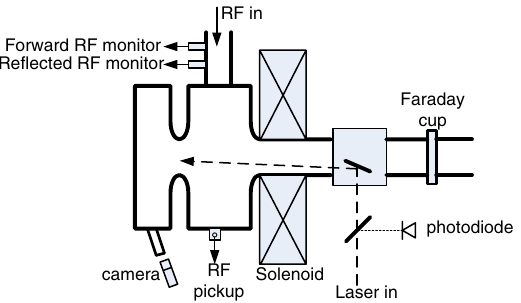
FIG. 1. Setup of the laser-triggered rf breakdown experiments at Tsinghua University.